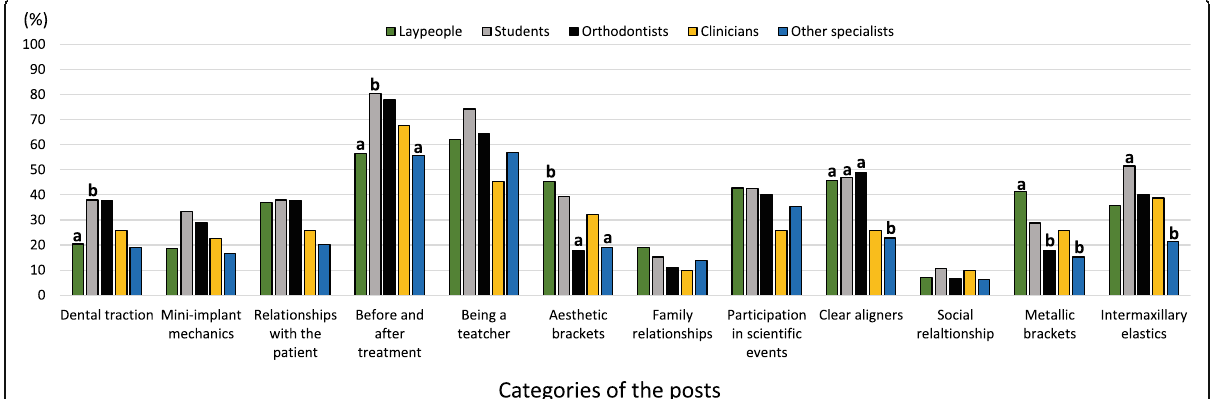
Fig. 3 Distribution of the variable “ willingness to become a client ” between groups, according to the different categories of the posts. Different letters mean statistical